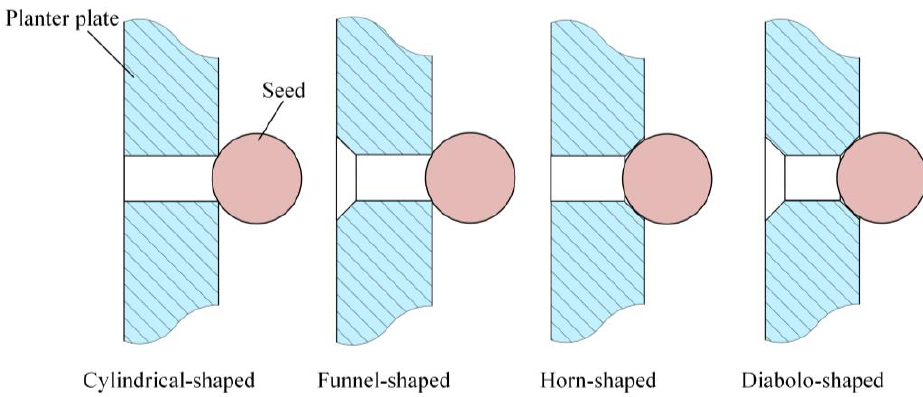
Figure 5. Different shapes of the suction hole structure